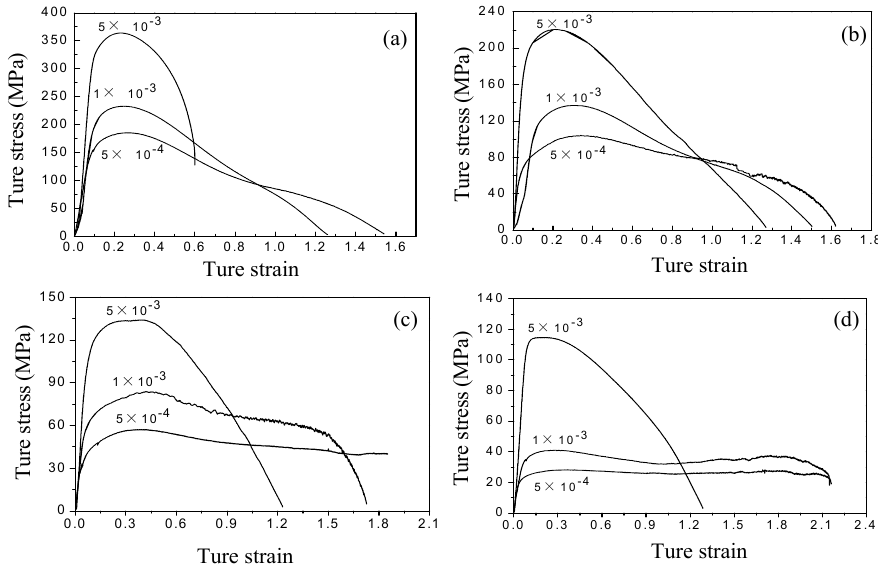
Figure 3. True stress versus strain curves during superplastic tension: ( a ) 973 K; ( b ) 1023 K; ( c ) 1073 K; ( d ) 1123